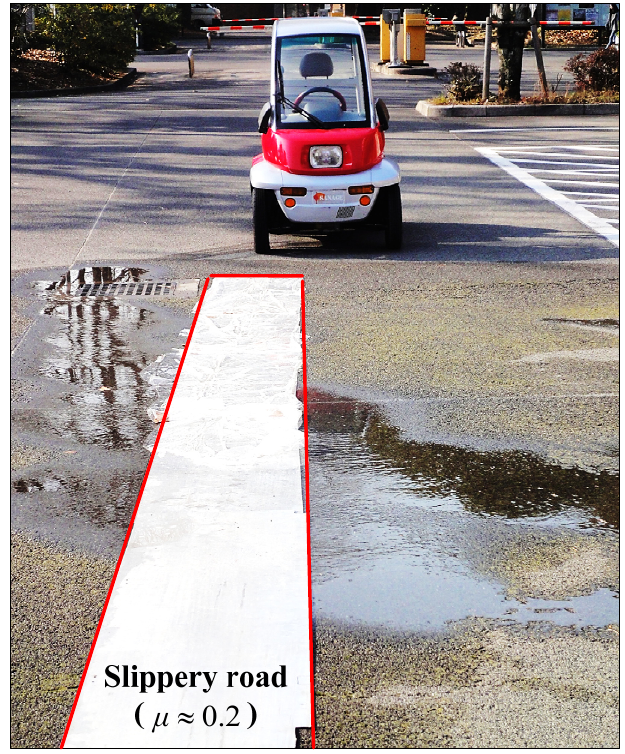
Figure 9. Experiment